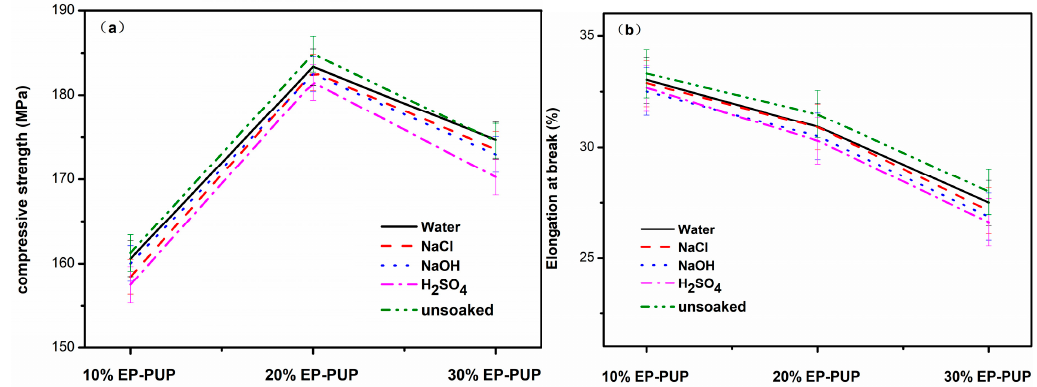
Figure 7. Mechanical properties of corroded samples at 0 °C. ( a ) The compressive strengths of modified epoxy after soaking in H 2 SO 4 , NaOH, and NaCl solutions. ( b ) The tensile strengths of modified epoxy after soaking in H 2 SO 4 , NaOH, and NaCl solutions.